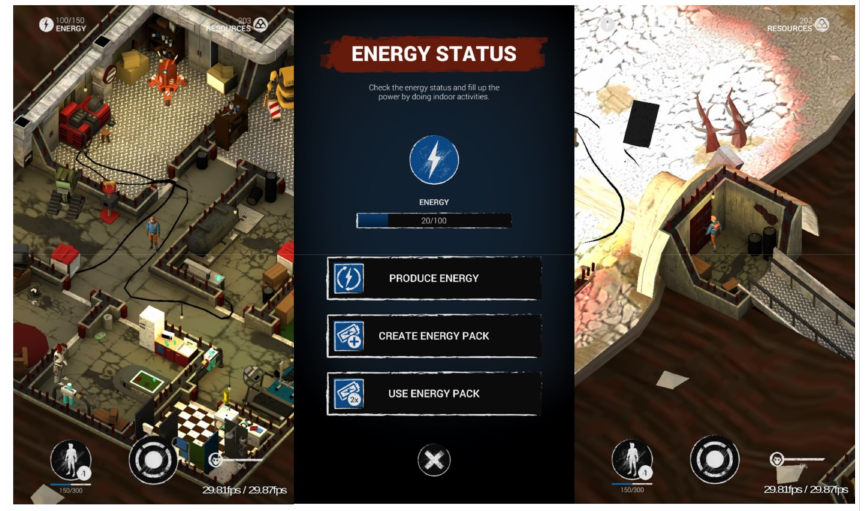
Figure 1. Impression of the game setting, similar in the dynamically tailored and non-tailored game